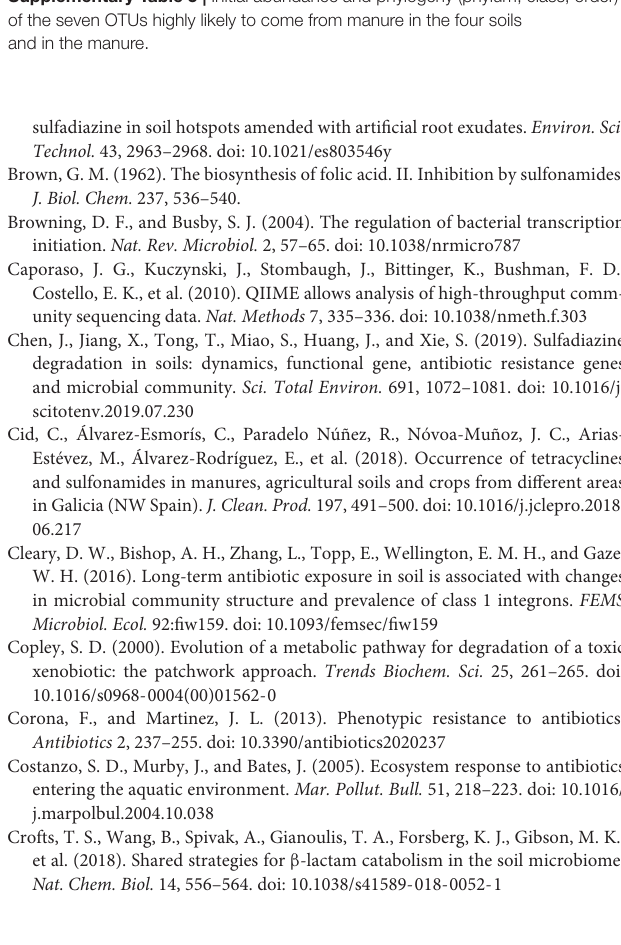
treatment. Supplementary Table 1 | GPS coordinates and physical-chemical properties of the four different soils used in the study. Supplementary Table 2 | Primers and probe used in this study.